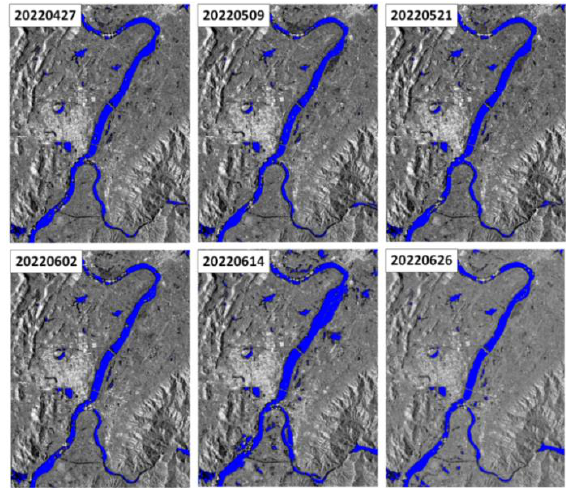
Figure 4 Water body extraction results of Yingde.